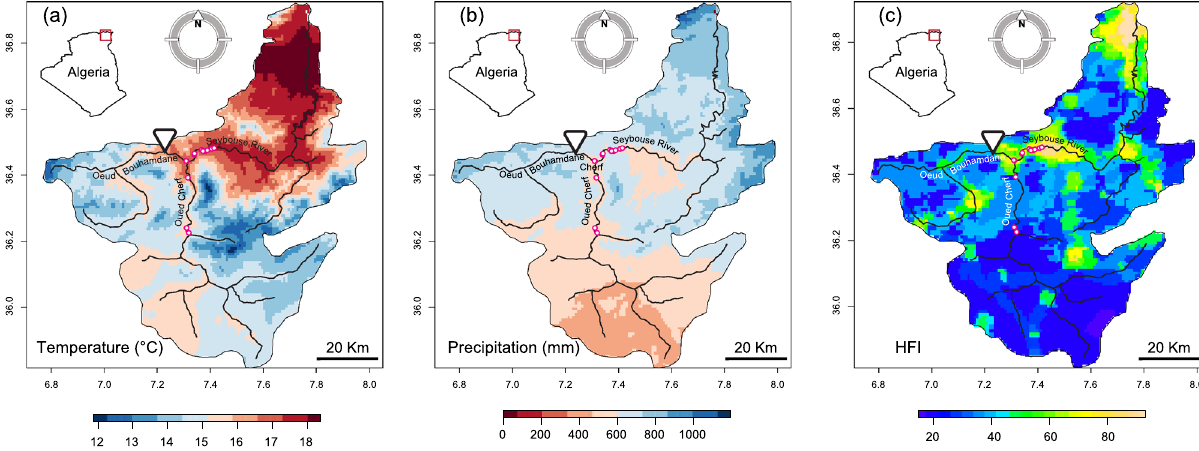
Figure 1. Some environmental characteristics and geographic location of the historical records of Calopteryx exul populations in the Seybouse watershed, Northeast Algeria. ( A ) Average annual temperature, ( B ) annual precipitation, and ( C ) human footprint index (HFI). Temperature and precipitation data represent an average across 30 years (1970–2000) and were obtained from WorldClim v2 77 . HFI ranges from 0 (low human influence) to 100 (very high human influence) 79 . Red circles are historical records of C. exul . Inverted triangle indicates